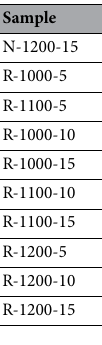
Table 2. List of the calculated CIE color space coordinates.